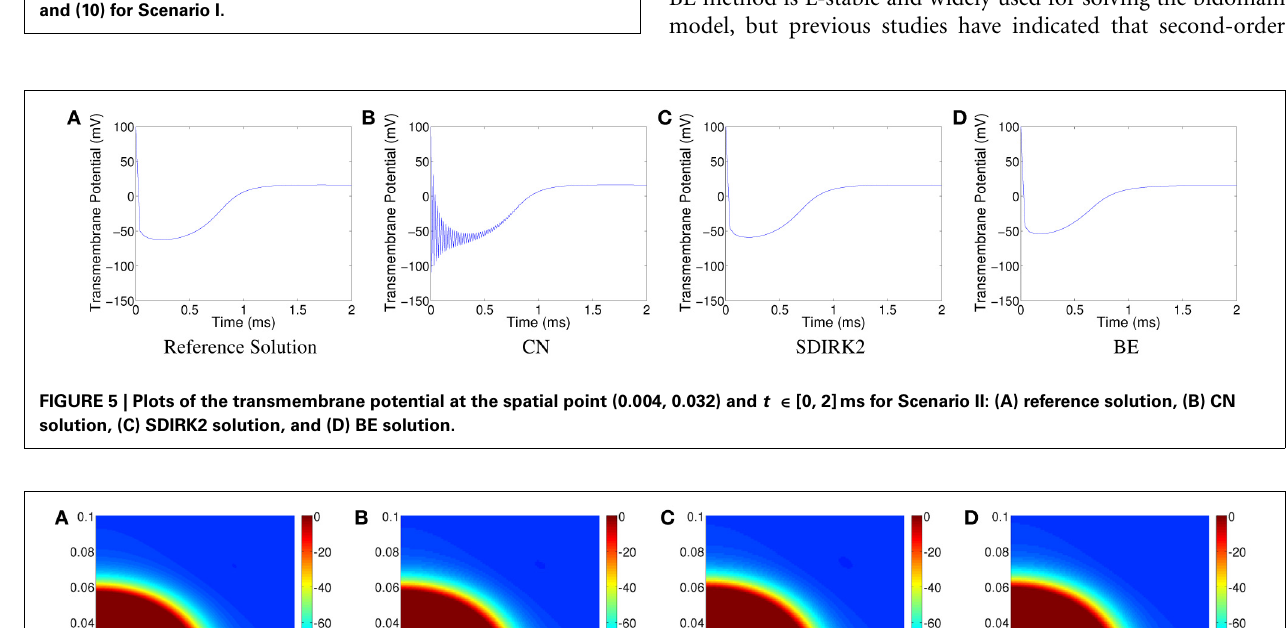
FIGURE 4 | CN and SDIRK2 amplification factors from Equations (9) and (10) for Scenario I.